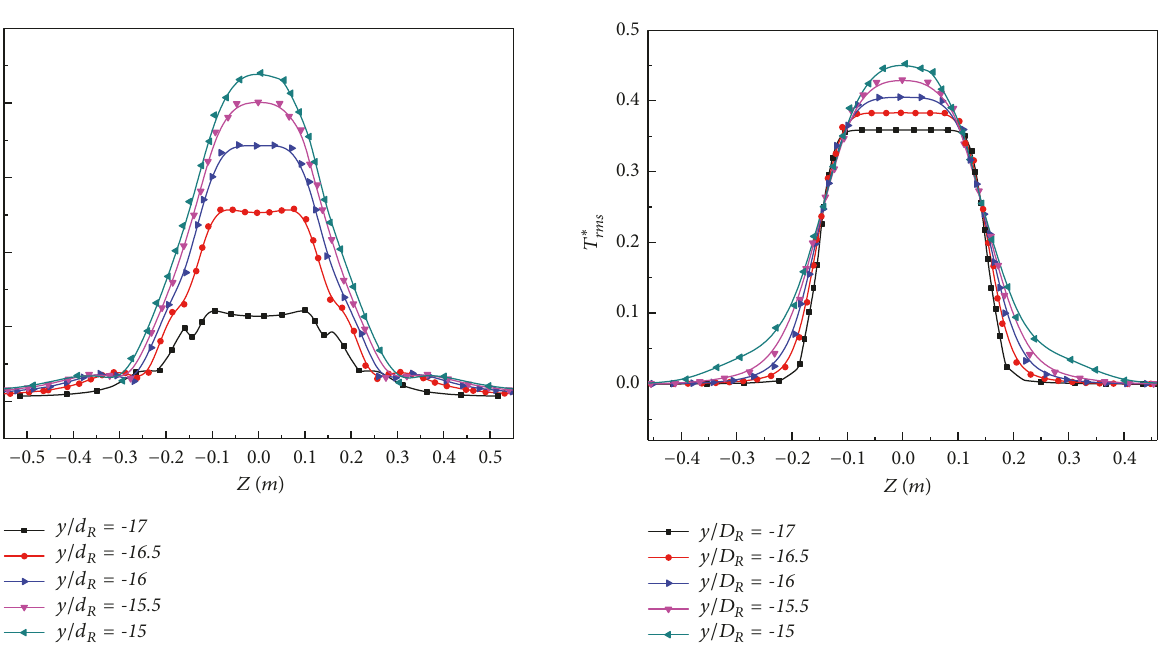
Figure 16: Dimensionless RMS velocity of different points in center plane.